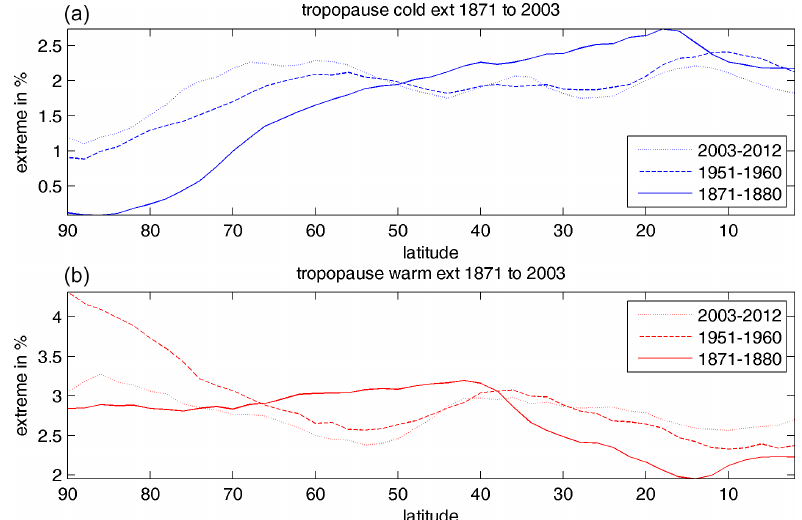
Figure 12. NCEP reanalysis data of tropopause temperature. Tropopause data have been chosen since the frequency spectra of the baroclinic- wave experiment look most similar to tropopause spectra (Rodda and Harlander, 2020). A number of extreme events in percent for different time slices and latitudes. The upper and bottom plots depict extreme cold and hot events, respectively. The lines are solid for 1871–1880, dashed for 1951–1960, and dotted for 2003–2012. The seasonal cycle has been removed from the data. The extreme values have been taken from the Pacific sector (weak land–sea contrast), and the frequencies from the Southern Hemisphere and Northern Hemisphere have been averaged for any latitudinal